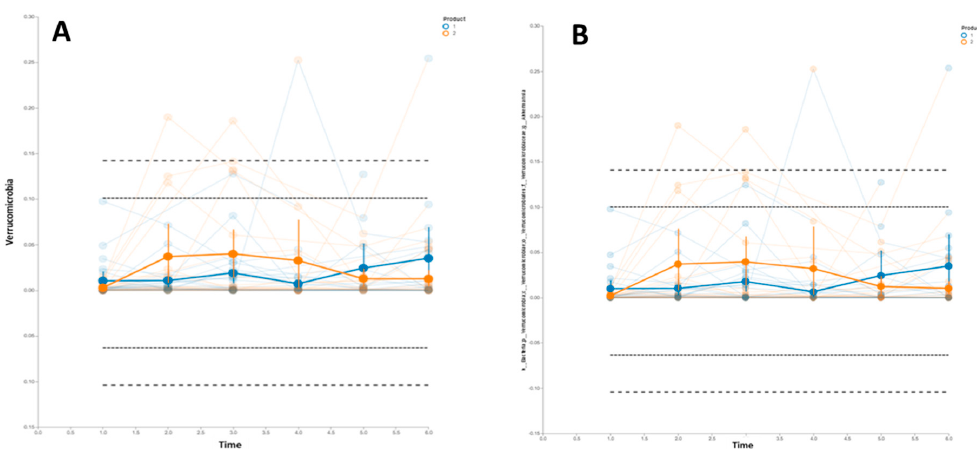
Figure 4. Trend of the relative proportion of Verrucomicrobia phylum and Akkermansia genus. The thick lines with error bars represent the means of both groups (Group 1: blue lines; group 2: orange lines). Dashed lines represent the means ± 2 and 3 standard deviations. Group 1 started the intervention receiving the placebo (t1, t2, and t3) and then was switched to receive the probiotic strain (t4, t5, and t6). Group 2 started the intervention receiving the probiotic strain (t1, t2, and t3) and then was switched to receive the placebo (t4, t5, and t6). ( A ) Temporal trend of Verrucomicrobia phylum; ( B ) Temporal trend of Akkermansia genus.